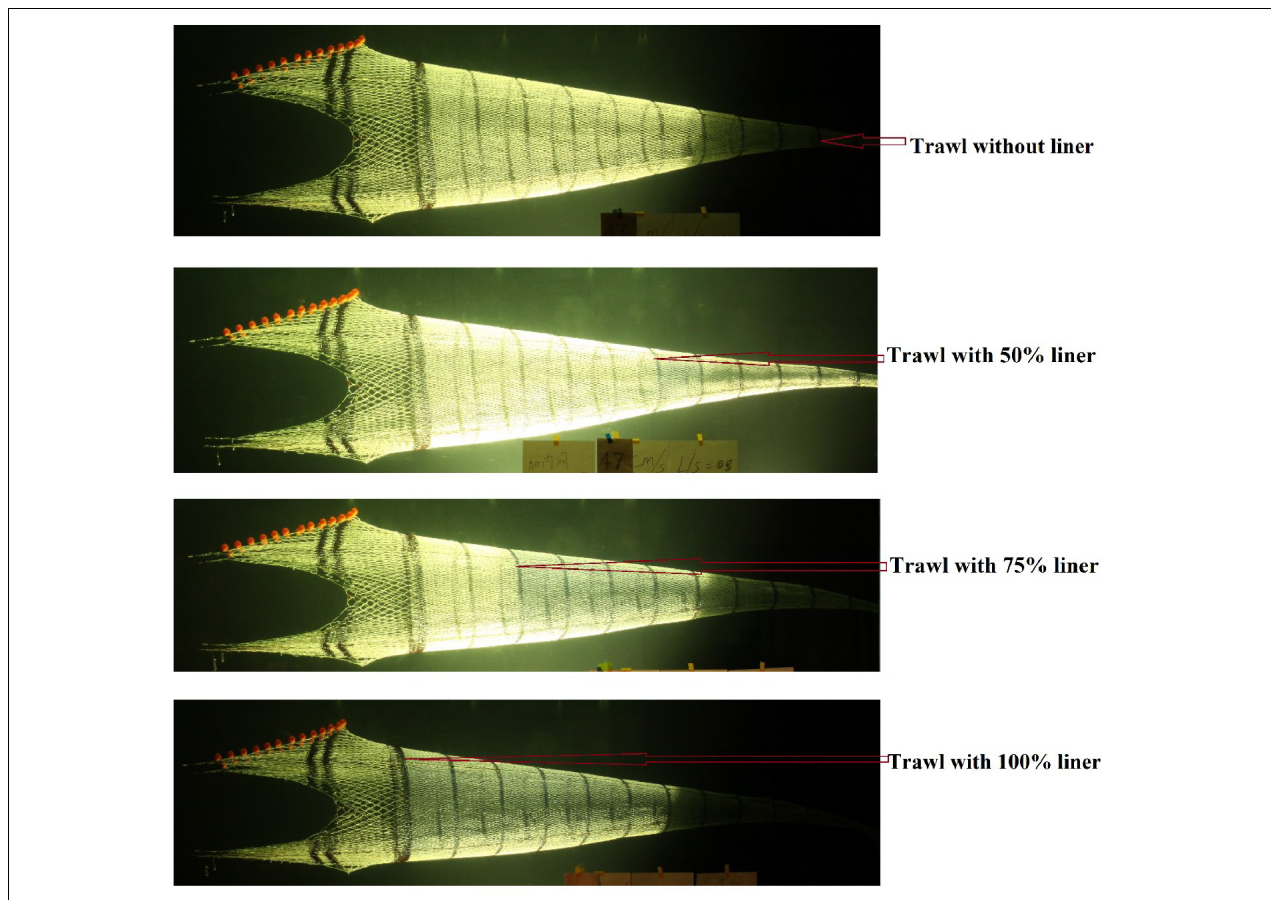
FIGURE 3 | Side views of the midwater trawl net in the flume